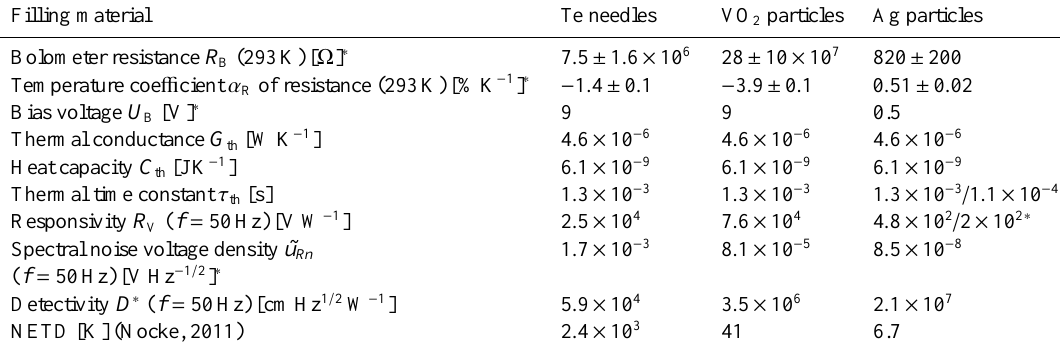
Table 2. Electrical and thermal properties of realized polymer composite based microbolometers; calculation of sensor responsivities R V and detectivities D ∗ according to the Eqs. (1) and (3); assumed absorption coe ffi cient α = 1. Filling material Te needles VO 2 particles